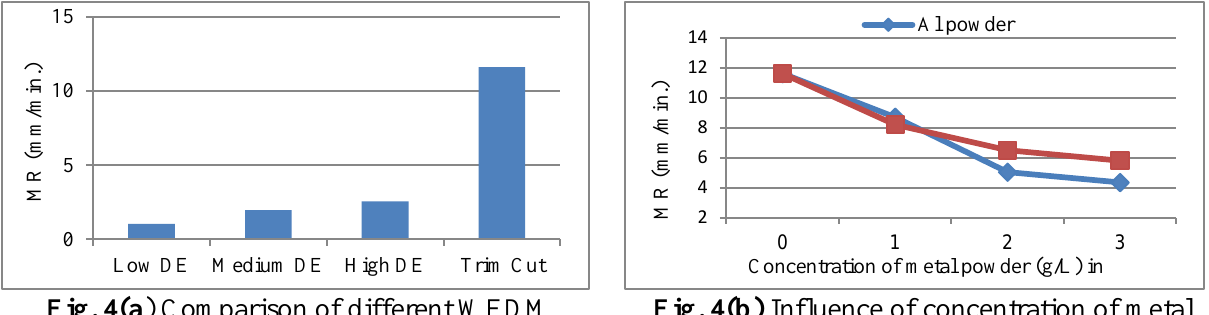
operations for MR